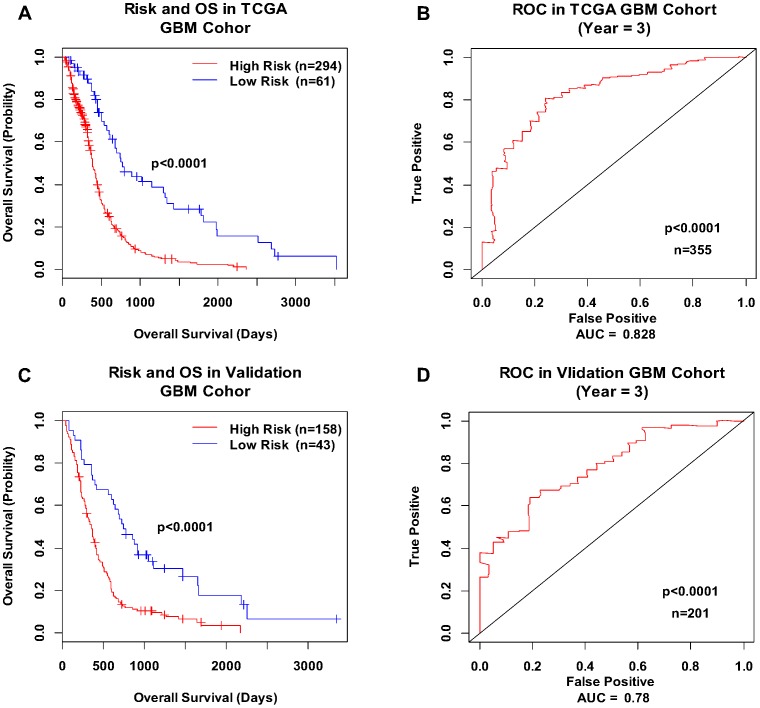
Kaplan-Meier curves and ROC curves for the integrated RNA signature.Kaplan-Meier plots for GBM patients in high-risk and low-risk groups segregated by the integrated RNA signature in the TCGA GBM cohort (A) and the validation cohort (C). The significance of survival difference between groups was evaluated by log-rank test (P = 1.02e-09 and 3.76e-08, respectively). The respective ROC curves had AUCs of 0.828 (B) and 0.780 (D). The permutation P value was computed to test the null hypothesis (AUC = 0.5) using 10,000 permutations.